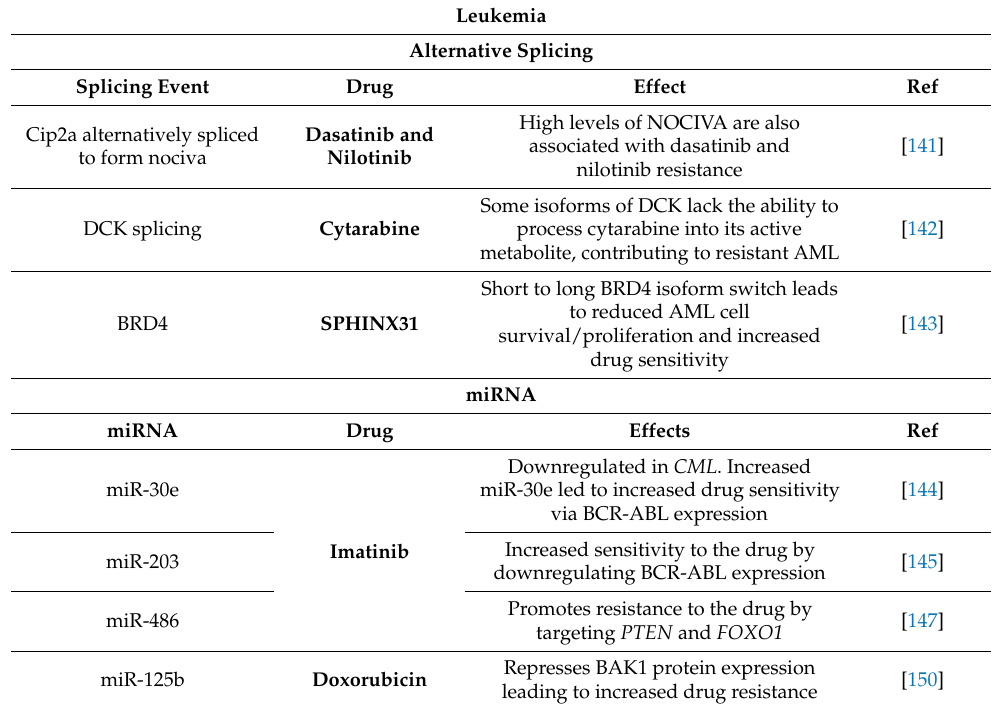
Table 5. Alternative splicing events and miRNAs involved in drug resistance in leukemia